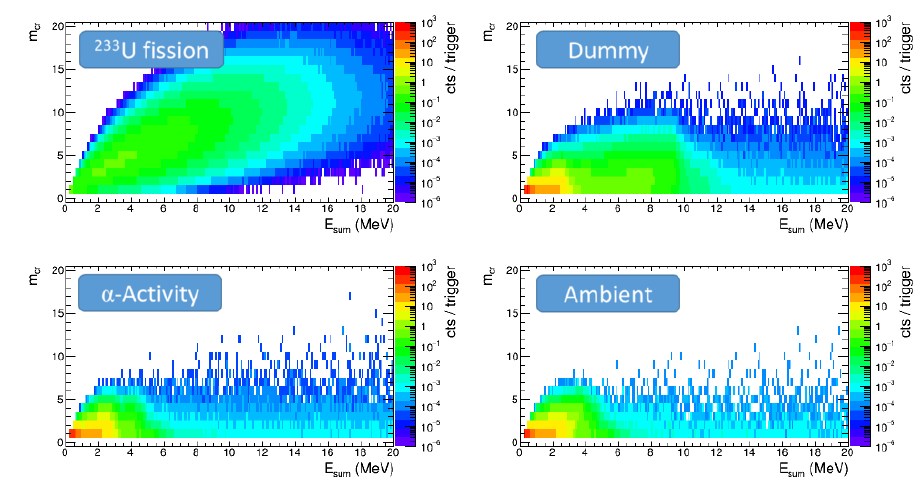
Fig. 8. TAC response for various background